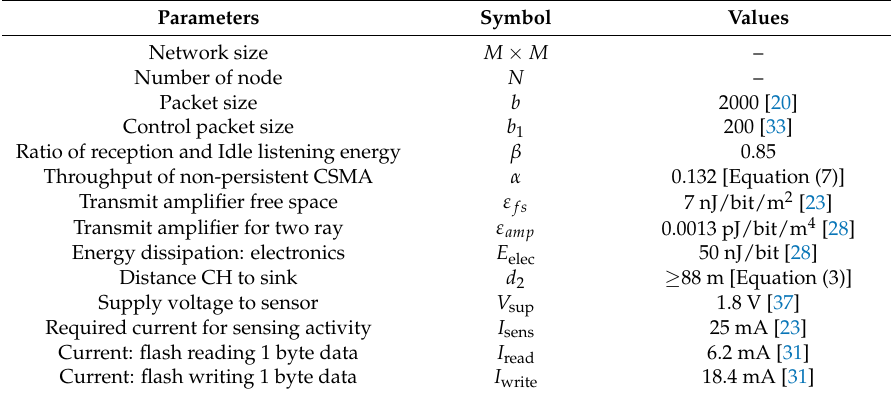
Figure 8. CH node energy dissipation versus the number of nodes and the network size d WSN − BS = 150 m. Table 2. Parameter values used in energy model.